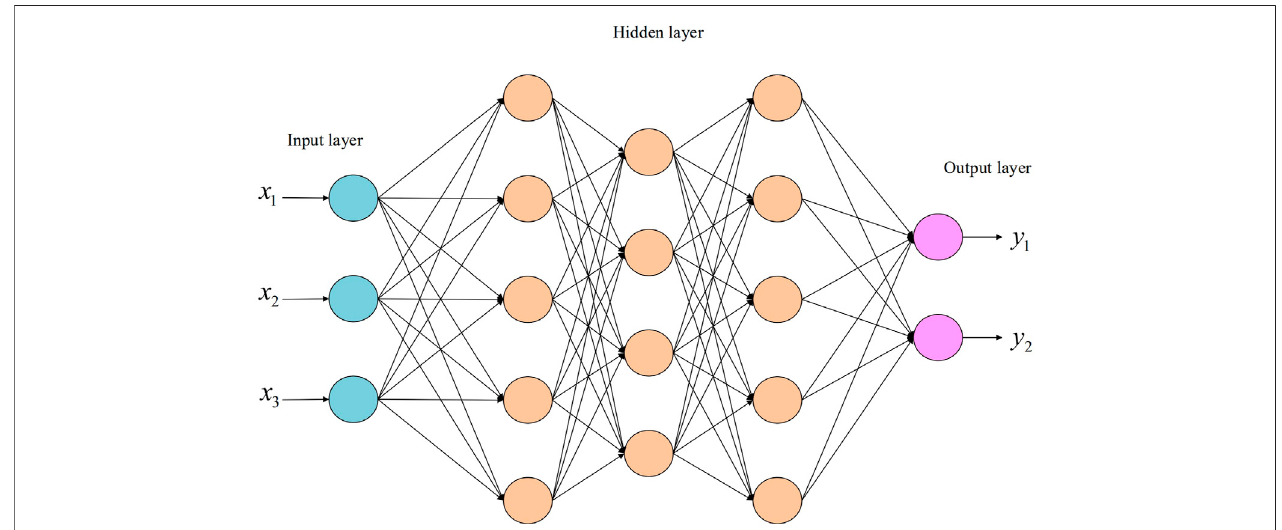
FIGURE 1 | Multilayer arti fi cial neural